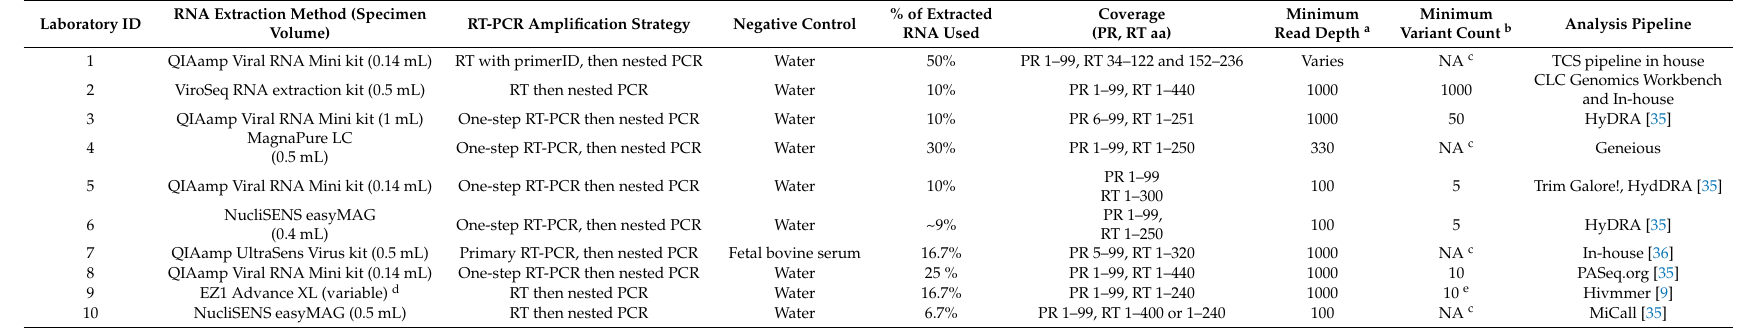
Table A1. Assay details.